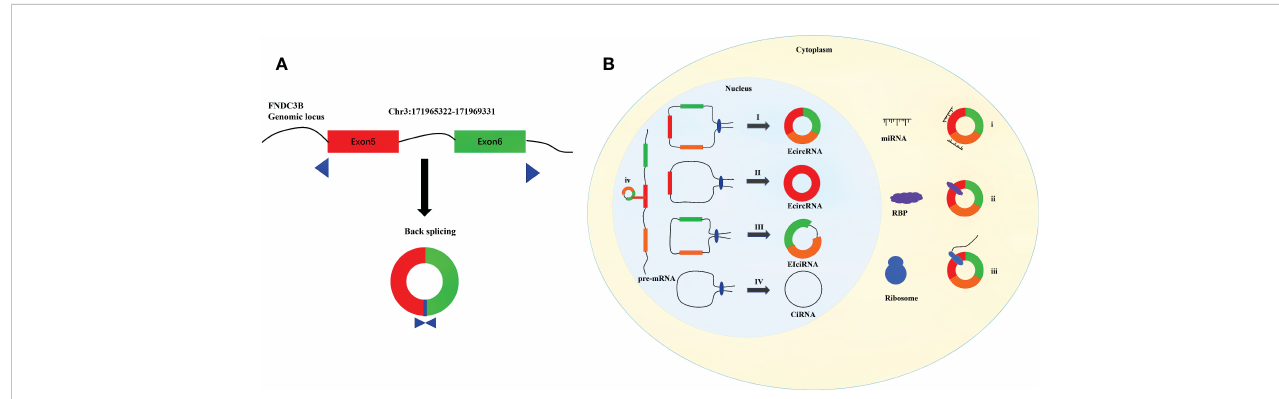
FIGURE 1 Diagram for biogenesis and functions of circRNAs. (A) Schematic diagram of the formation of circFNDC3B. (B) I. The downstream 5 ‘ end of one exon is connected to the upstream 3 ’ end of another exon and cyclized to produce EcircRNA. II. The 5 ‘ end of certain exon is attached to the 3 ’ end of the same exon to produce EcircRNA. III. Intron pairing driven circularization to produce EIciRNA. IV Conserved sequences near the spliceosome to produce CiRNA. і . MiRNA sponges. ii. Interaction with functional proteins. III. Translation into peptides and/or proteins. iv. Regulation of gene